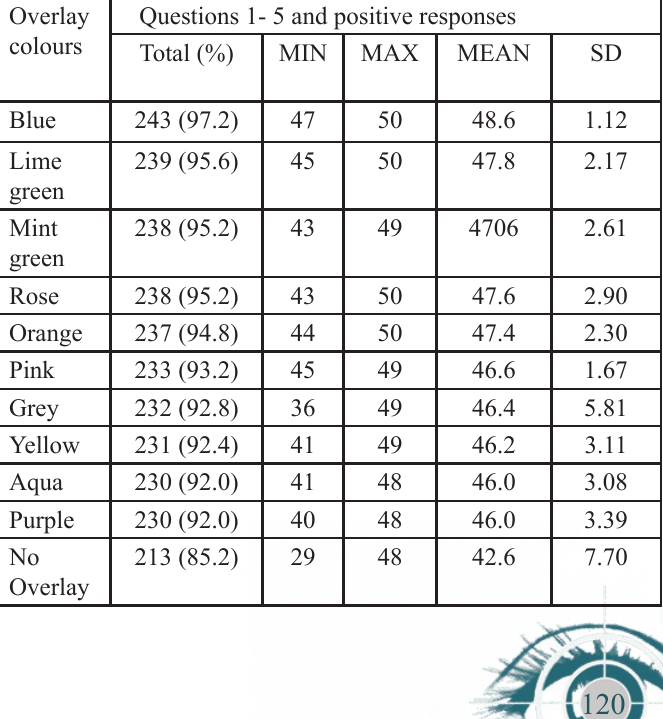
Table 2 . The total and percentage, minimum, maximum, mean and standard deviation of the positive responses (N=50) for the single overlays, for the five questions asked. The values are presented in order of decreasing total